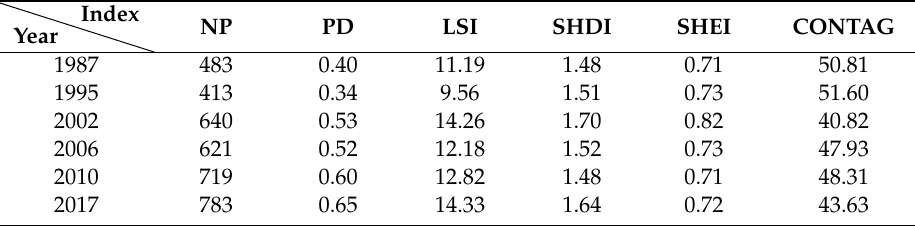
Table 5. The landscape metrics in Nansi Lake wetland from 1987 to 2017.